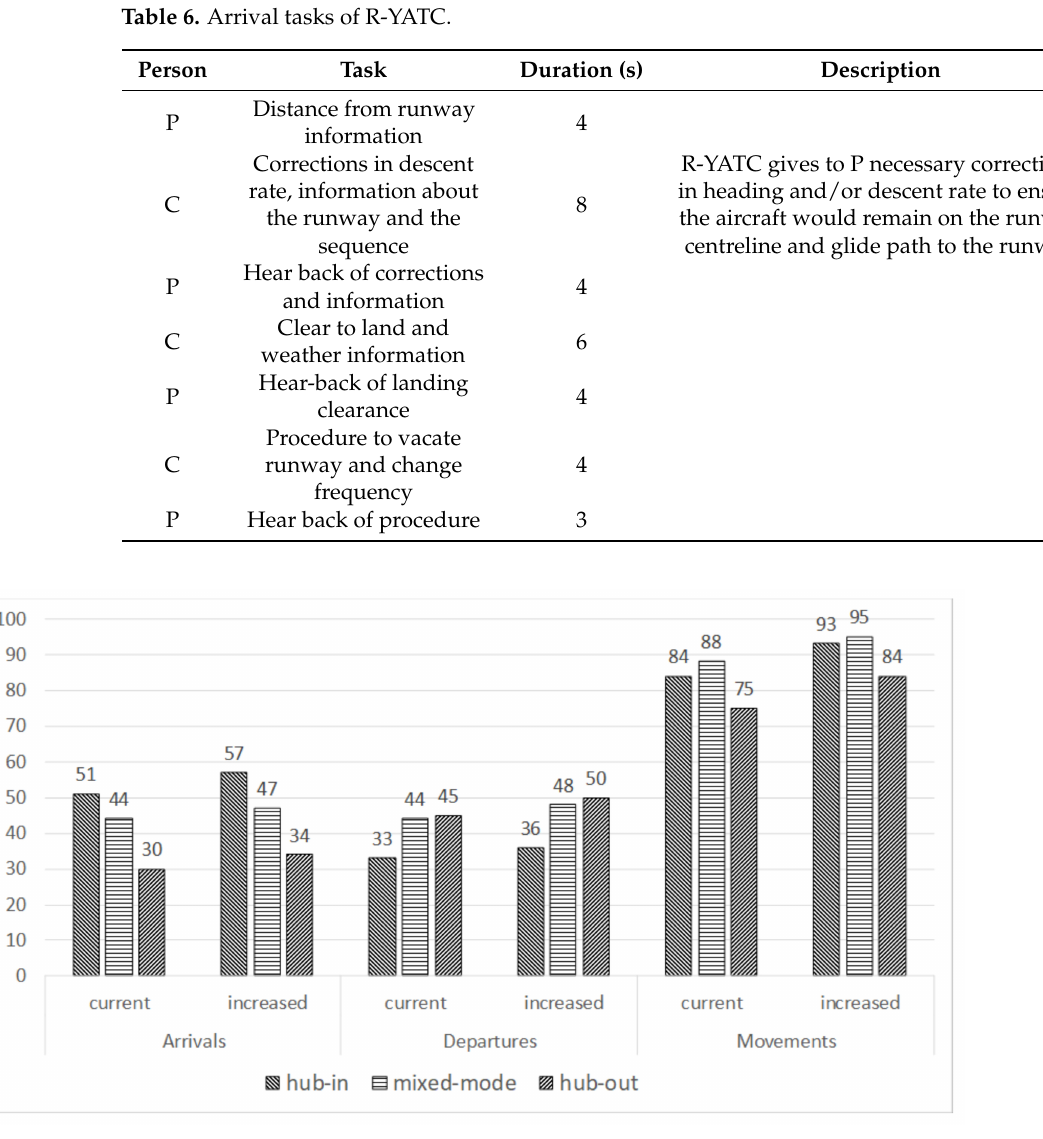
Figure 2. Throughput of each examined